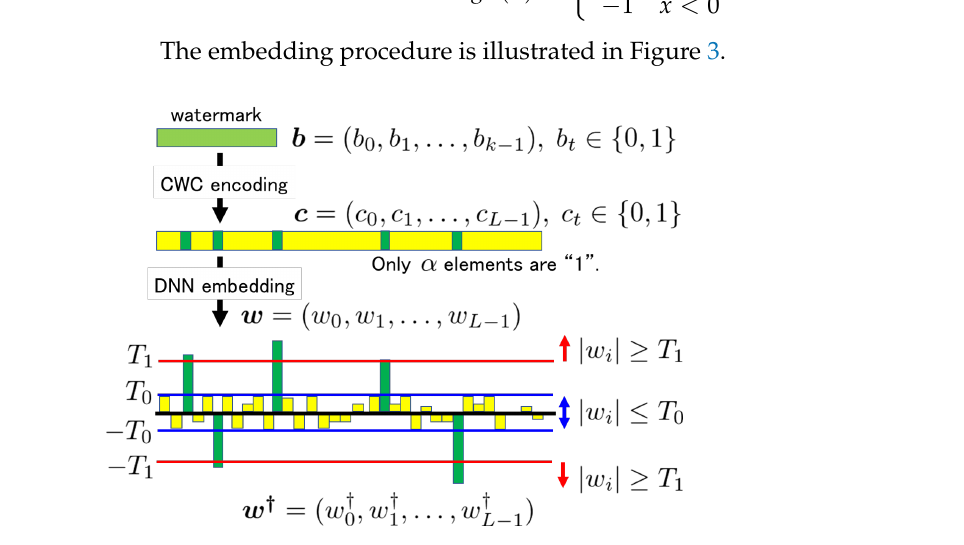
Figure 3. Illustration of embedding